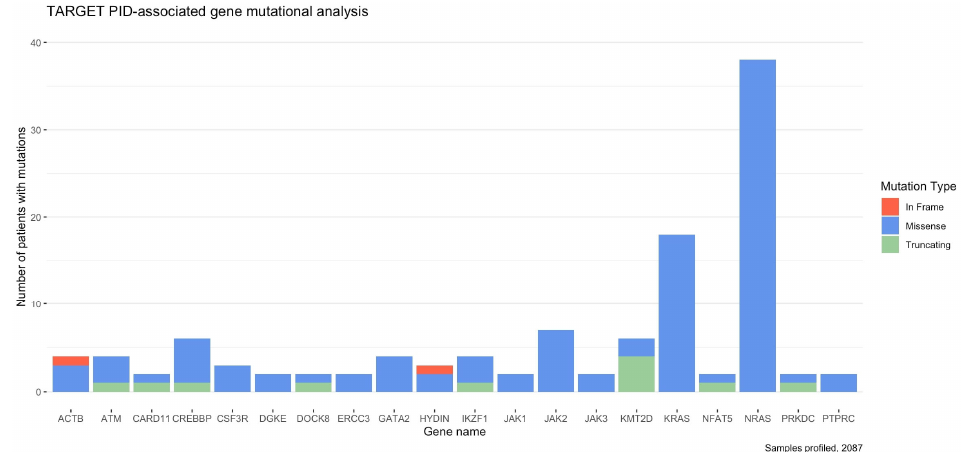
Figure 3. Mutation frequency of PID-related genes that are mutated in at least two of 2087 pediatric cancer patients profiled in AML, ALL, WT, RT, or NBL datasets. Classification of each mutation as being missense (blue), truncating (green), or in frame (red) is indicated in the stacked bar graph. Mutation profile was obtained from